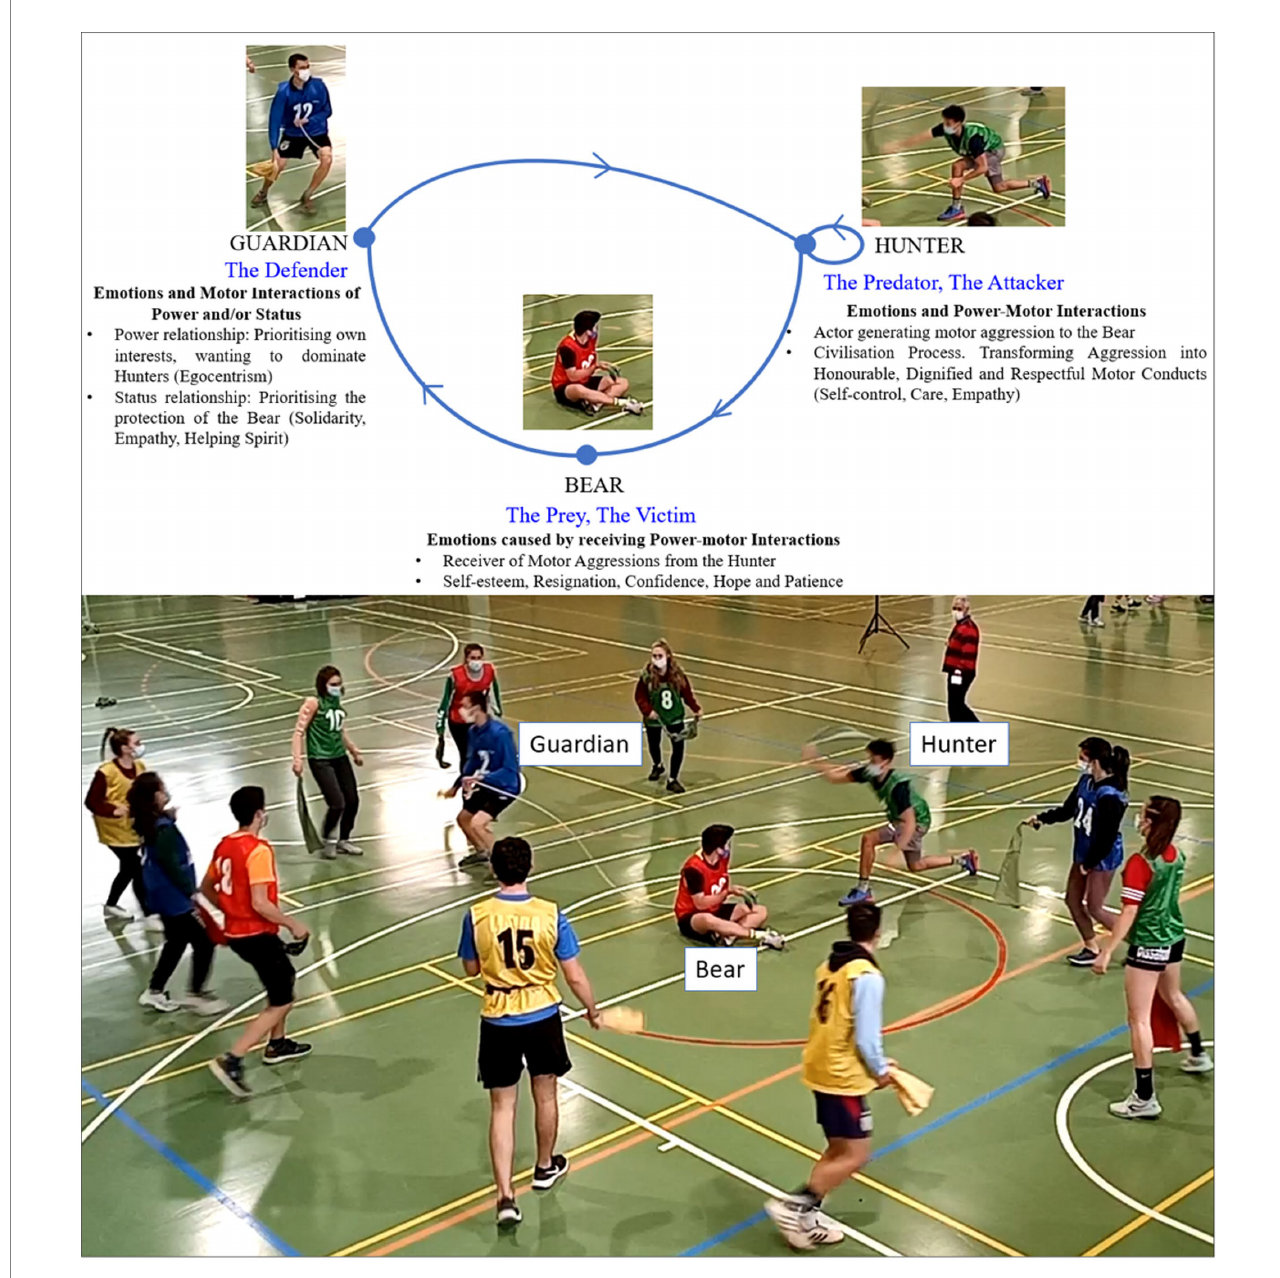
FIGURE 12 The chained role changes network. Emotions and status/power motor interactions. The line represents the change of role. The dot corresponds to the role. The loop over the Hunter role shows that when a role change occurs, some players remain in the same role, as only one hunter changes to the Bear